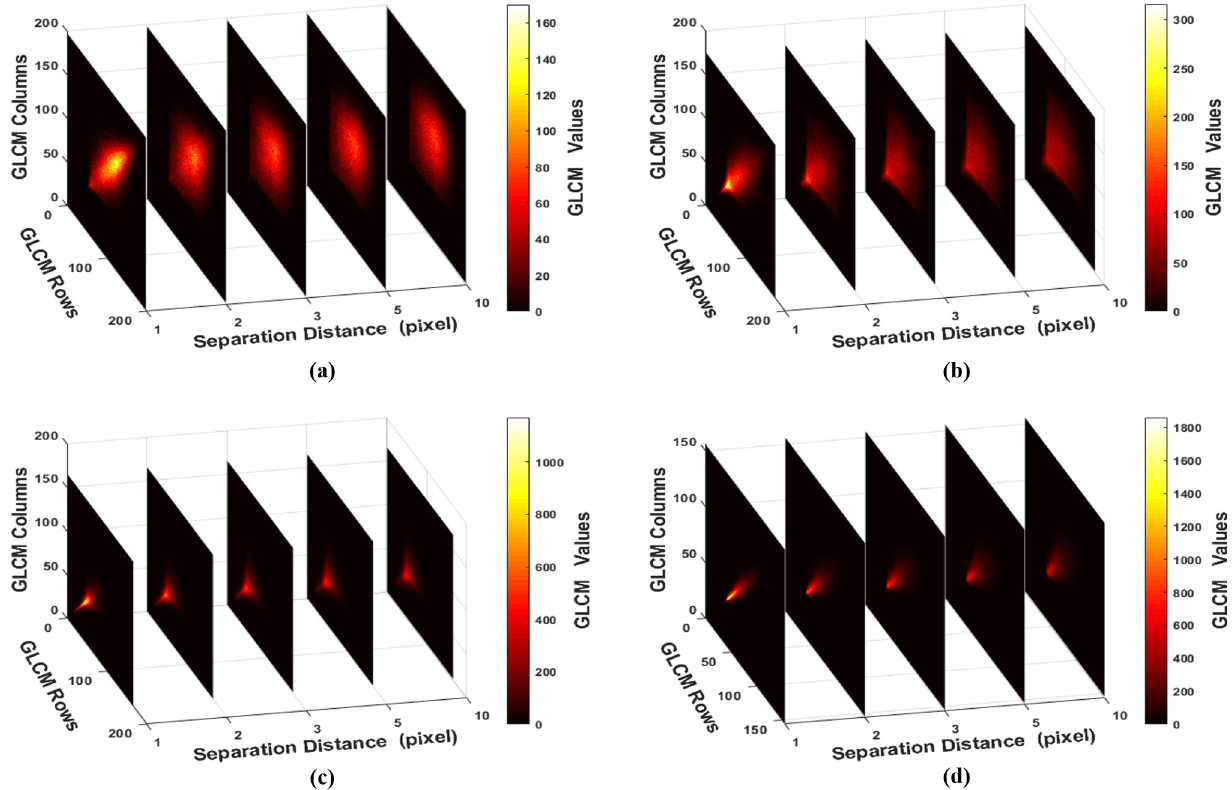
Fig 5. GLCM plots along the horizontal direction at d = 1,2,3,5 and 10 pixels of biospeckle images collected from cross-section areas of: (a) Ra = 10 nm, (b) Ra = 170 nm, (c) Ra = 1600 nm and (d) Ra = 2500 nm.